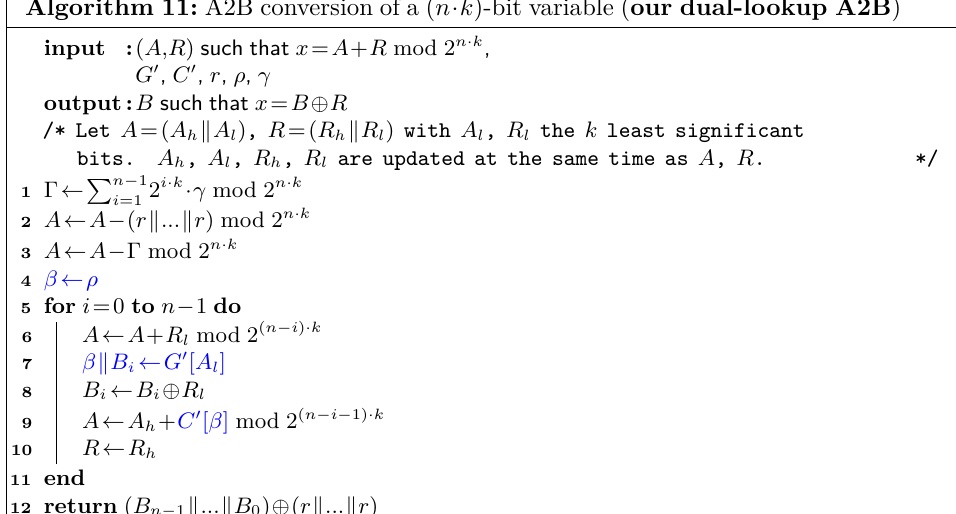
Algorithm 11: A2B conversion of a ( n · k )-bit variable ( our dual-lookup A2B